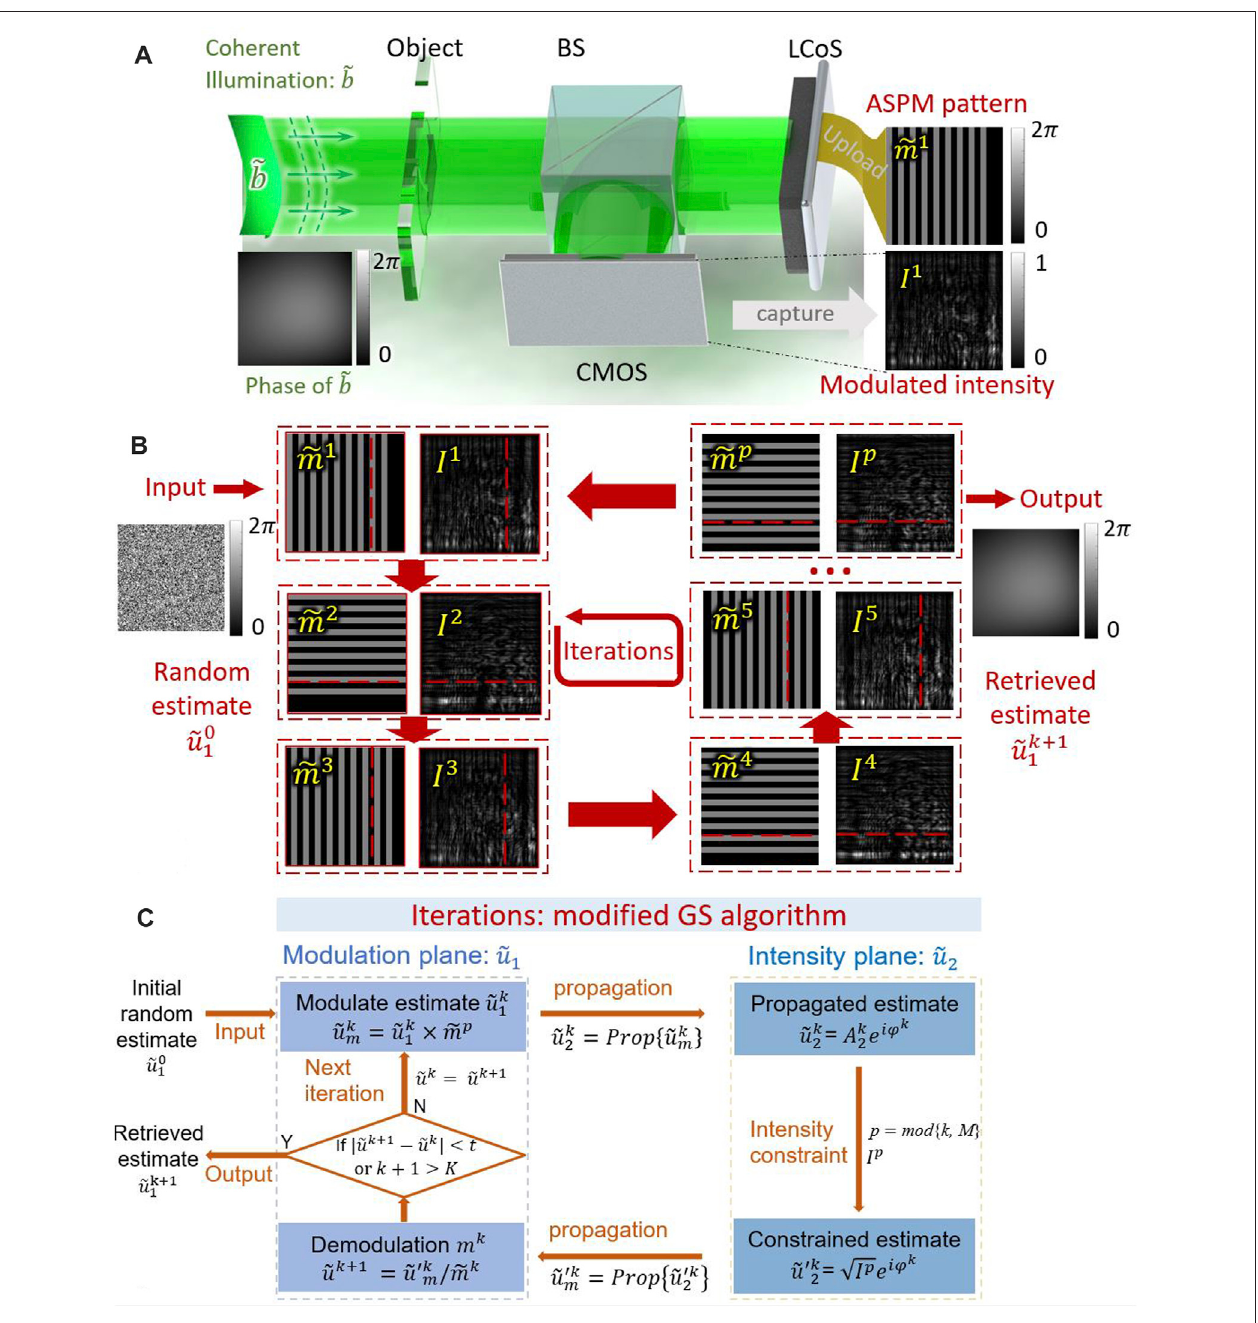
FIGURE2|(A) SchematicofdiffractionimagingusingtheASPMmethod. (B) UploadedASPMpatternsontheLCoSandcorrespondingmodulatedintensities. (C) Flowchart of the iterations using ASPM method. ~ m 1 : the fi rst ASPM modulation pattern. I 1 : the fi rst modulated intensity; k : number of iterations; p : number of modulations; M : total number of the constraints; mod { · } is the operator to calculate the remainder after division; t : the preferable value of the calculation error; K : a set maximum number of